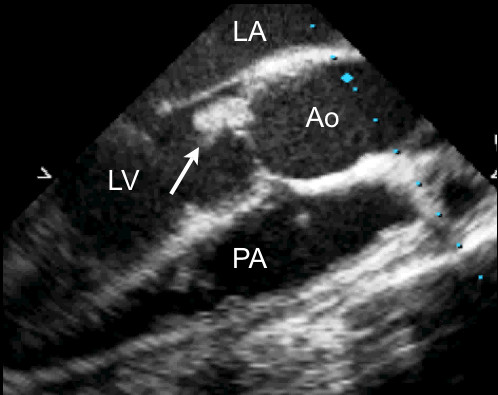
A transesophageal long axis view of the aorta in the same patient with demonstration of the vegetation on the noncoronary cusp of the aortic valve (arrow). LV, left ventricle; LA, left atrium; Ao; aorta; PA, pulmonary artery.